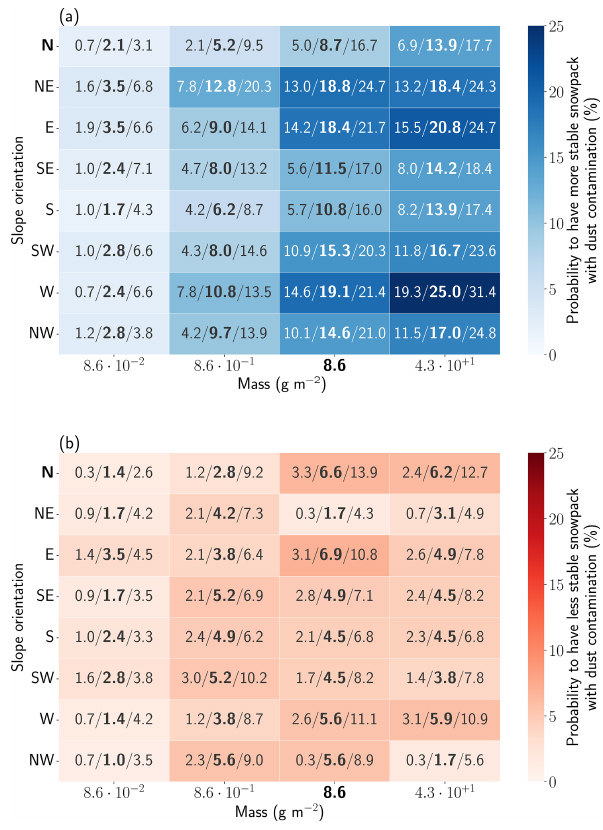
Figure 6. Probability for (a) a more stable (negative (cid:49) M ) and (b) a less stable (positive (cid:49) M ) snowpack due to dust deposition on the eight slope aspects for four different dust deposition masses: 8 . 6 × 10 − 2 , 8 . 6 × 10 − 1 , 8 . 6 and 4 . 3 × 10 + 1 gm − 2 . The (cid:49) M index represents the difference in dry-snow stability between dust and no- dust simulations. The values are calculated from 5 March to 9 April (280 time steps) corresponding to P ( < 0,all) for (a) and P ( > 0,all) for (b) . The deposition value of 8.6gm − 2 correspond to the previ- ously studied configuration (Sect. 3.2.1 and 3.2.2). The values in- dicated in the cells are the median (in bold) and the first and third quartiles. All values are percentages referring to the probability for a negative or a positive